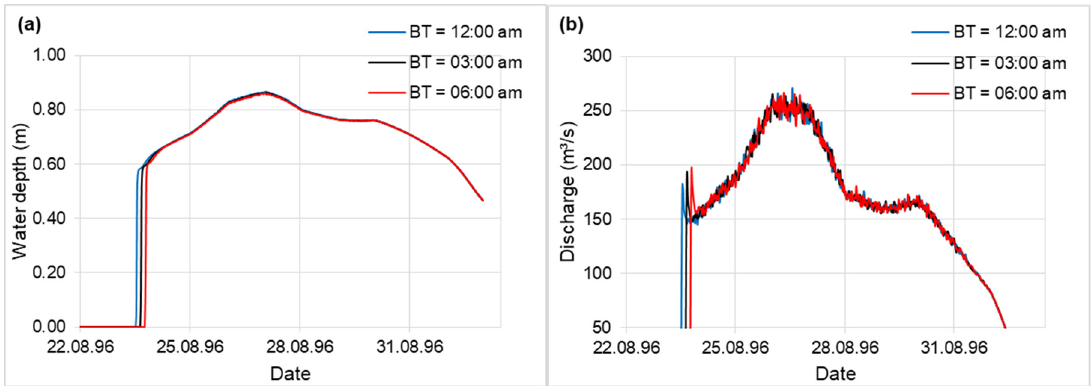
Figure 9. For the indicated levee breach start times (BT) on 24.08.1996 and the historical levee breach location of the August 1996 levee breach flood event at Wonji, ( a ) modelled water depth at an office location and ( b ) modelled breach discharge. The office location and the historical breach location are shown in Figure 3.